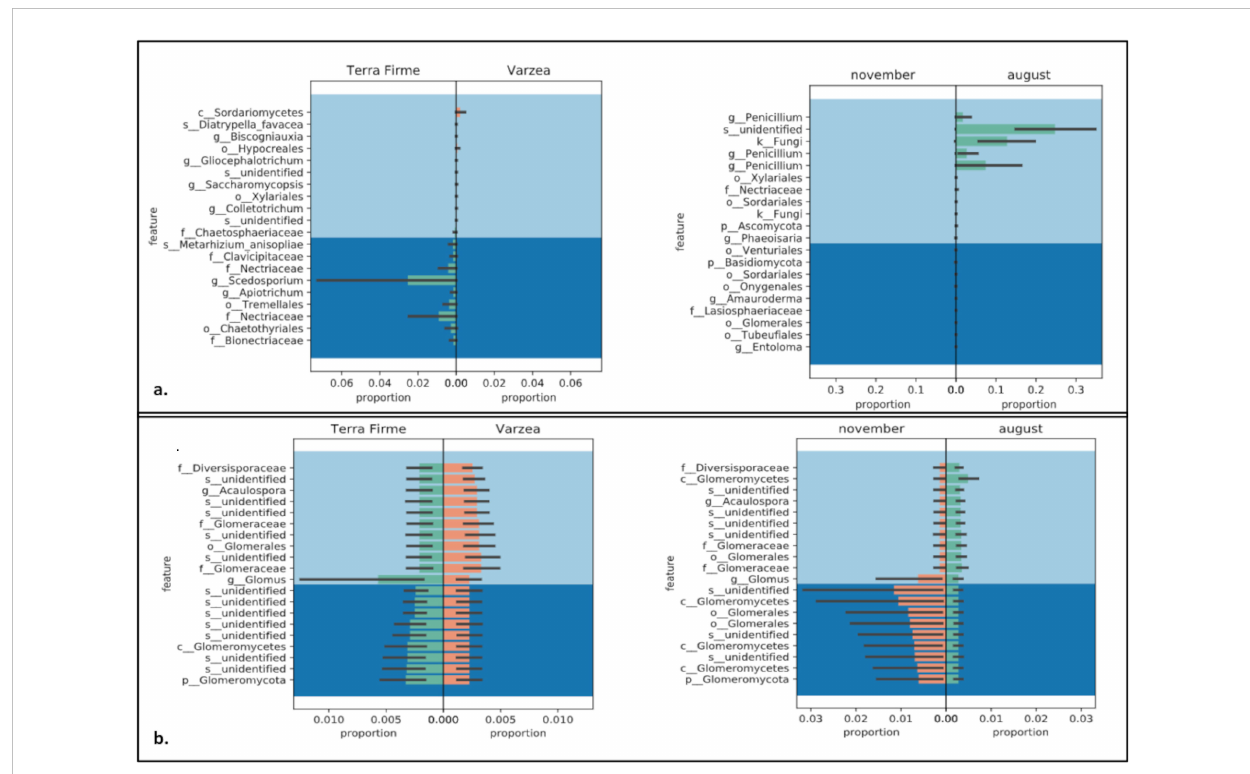
FIGURE 4 Comparison of abundances of fungal and Glomeromycotina taxa analyzed by Gneiss metrics. Panels show differentially abundant Fungi (A) and Glomeromycotina (B) associated to the rhizosphere of Inga seedlings collected in terra fi rme or va ́ rzea forest ecosystems (left panels) or sampled in November 2018 and August 2019 (right panel). Taxons are described to the taxonomic most detailed annotation: P, phylum; c, class; o, order; f, family; g, genus; and s,